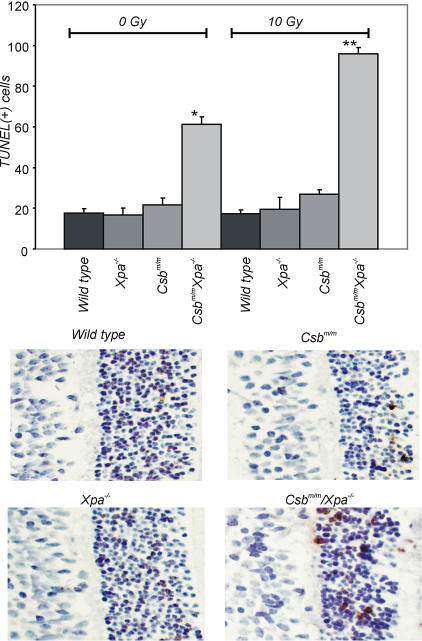
Enhanced Sensitivity of Csbm/m/Xpa−/− Retinal Photoreceptor Cells to Genotoxic InsultsRepresentative pictures of TUNEL stained retinas of 19-d-old wt, Csbm/
m
, Xpa−/−, and Csbm/m/Xpa−/− mice (right panel), 20 h after exposure of animals to 10 Gy of ionizing radiation, and quantification of the number of TUNEL positive cells in the ONL (left panel). Note the significantly higher number of TUNEL-positive cells in the retina of Csbm/m/Xpa−/− mice, as compared to wt and single-mutant littermate controls (p < 0.05). Single asterisks indicate statistically significant differences between unirradiated Csbm/m/Xpa−/− and littermate control mice (p < 0.05), double asterisks indicate statistically significant differences between unirradiated and irradiated Csbm/m/Xpa−/− mice (p < 0.05).